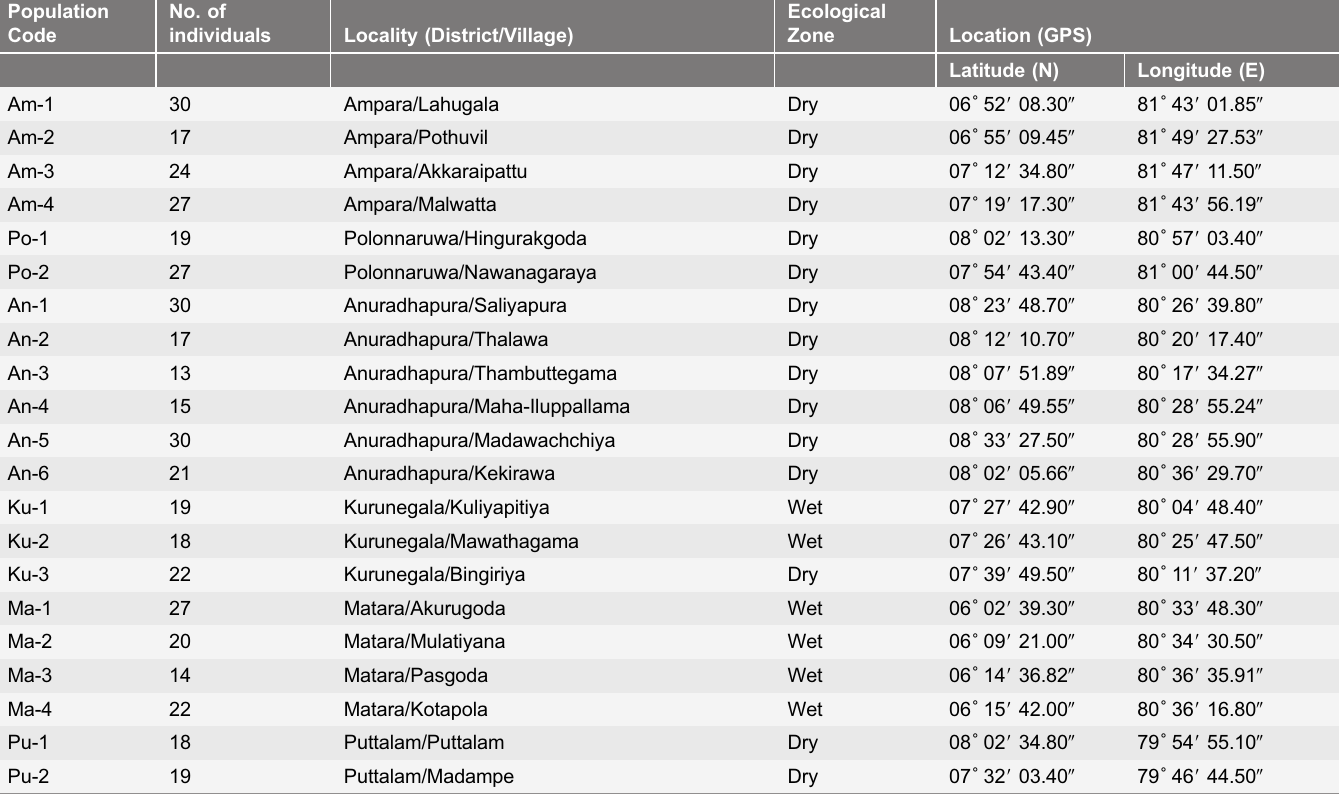
Table 1. The twenty-one weedy rice populations collected from different geographical locations in Sri Lanka with their GPS readings. Population